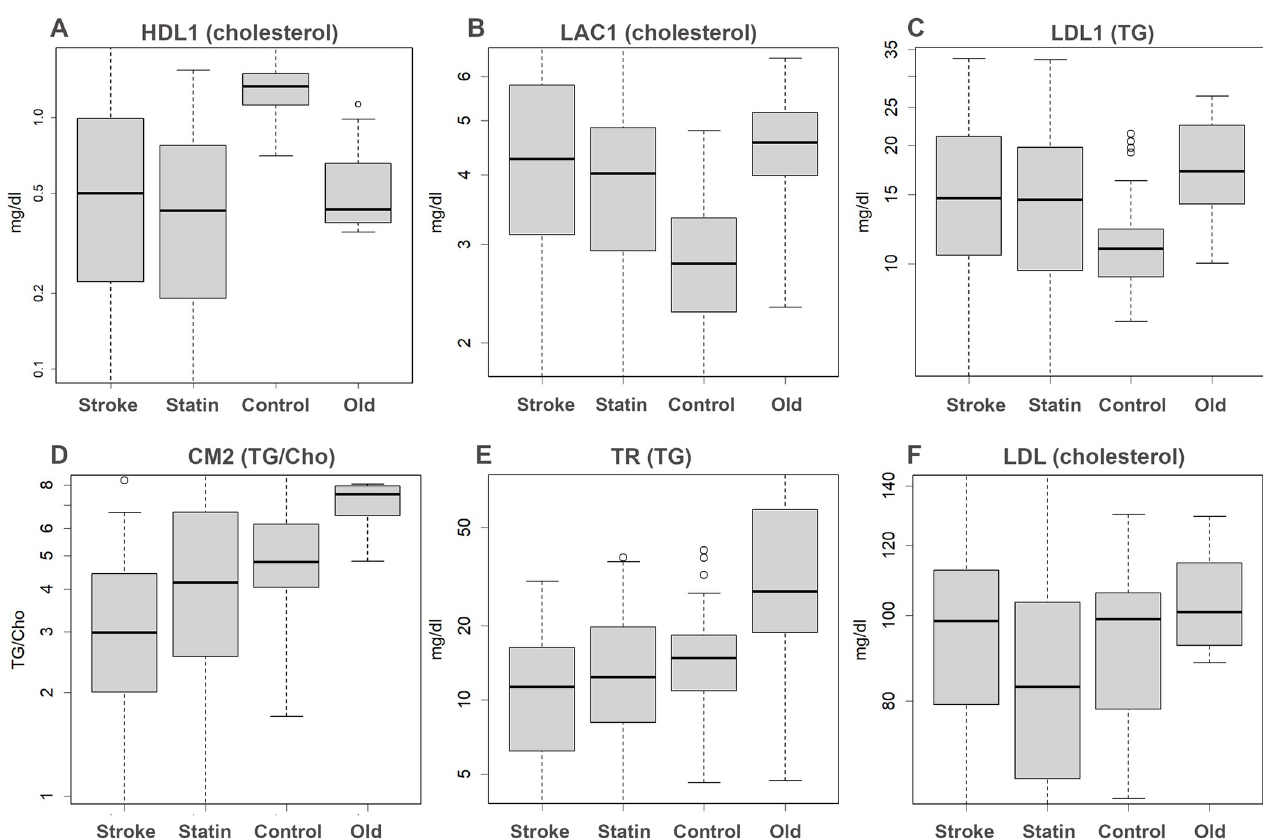
Fig 2. Boxplots. Each of these is an amount or a ratio for the class indicated. A . Largest difference was observed in HDL1 cholesterol, which was decreased in the patients, B and C . Higher LAC1 cholesterol and TG of LDL1 are risks, D . TG/cholesterol ratio of CM, showing this ratio in the diet, E . TR (TG-rich VLDL), F . LDL cholesterol, which is the target of statins. The y-axis is shown logarithmically.